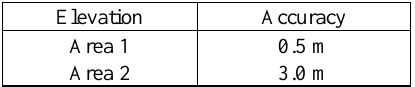
Table 1. Accuracy of obstacle